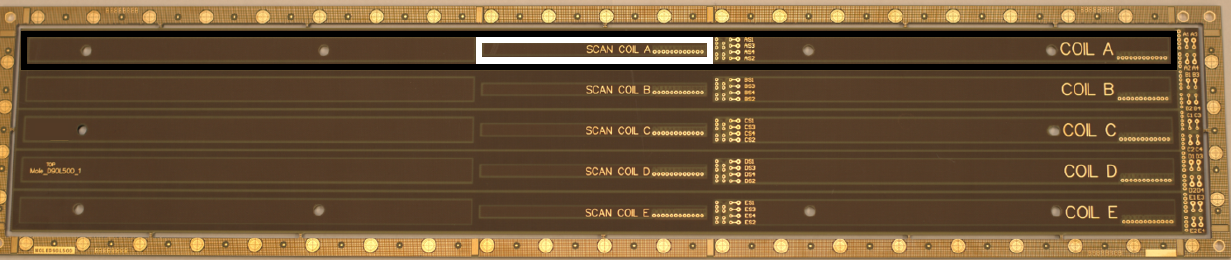
Figure 4. The PCB board containing an array of 10 coils. The top 500 and 100mm long coils are marked with black and white rectangles, respectively.